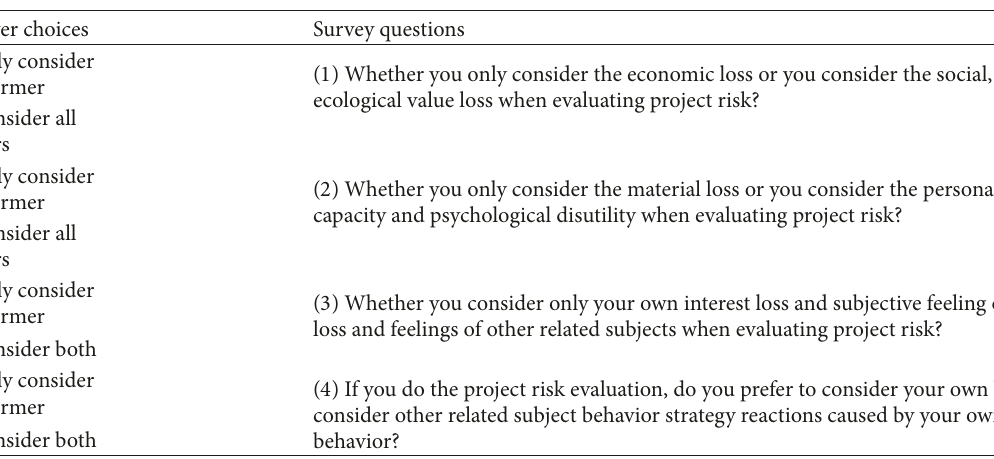
Table 1: Subject risk evaluation motivation questionnaire of major infrastructure